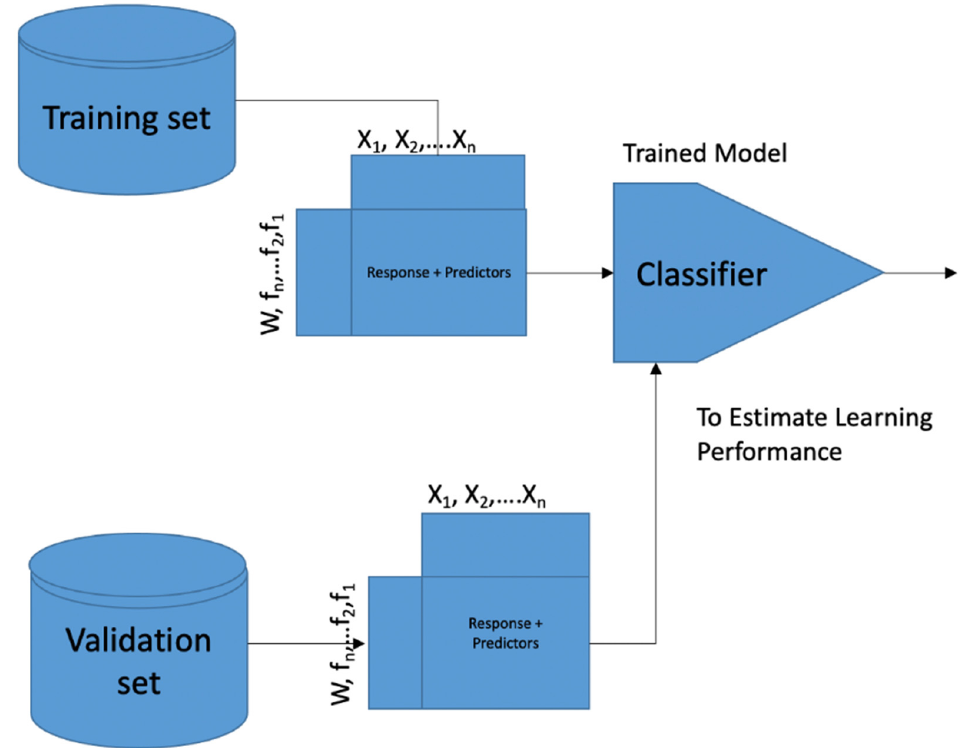
Figure 1. The learning procedure of an SVM classifier.